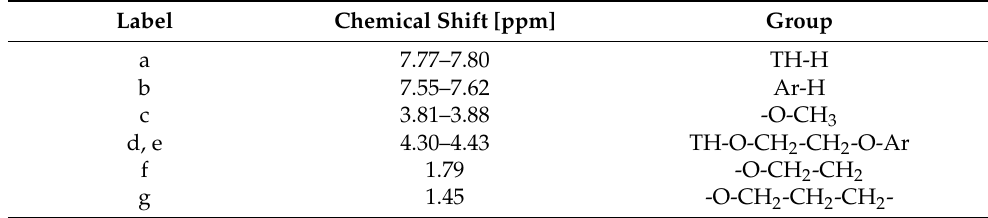
Table 3. Characteristic 1 H NMR signals for copolyesters (see Figure 4 for reference to Label letters).